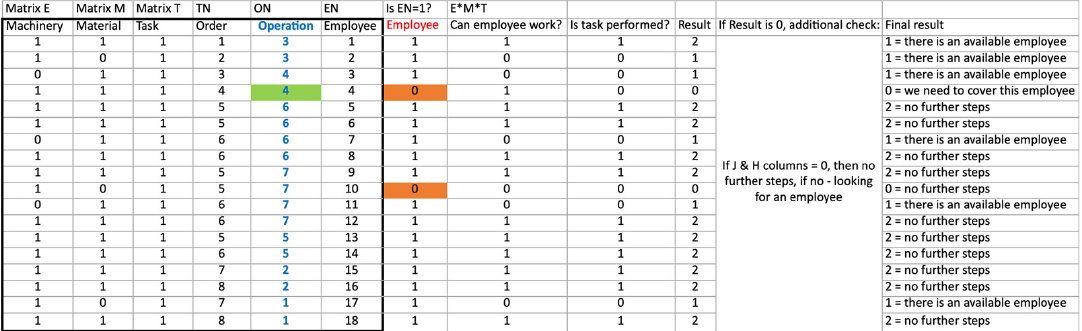
Figure 5. Results of the algorithm testing.